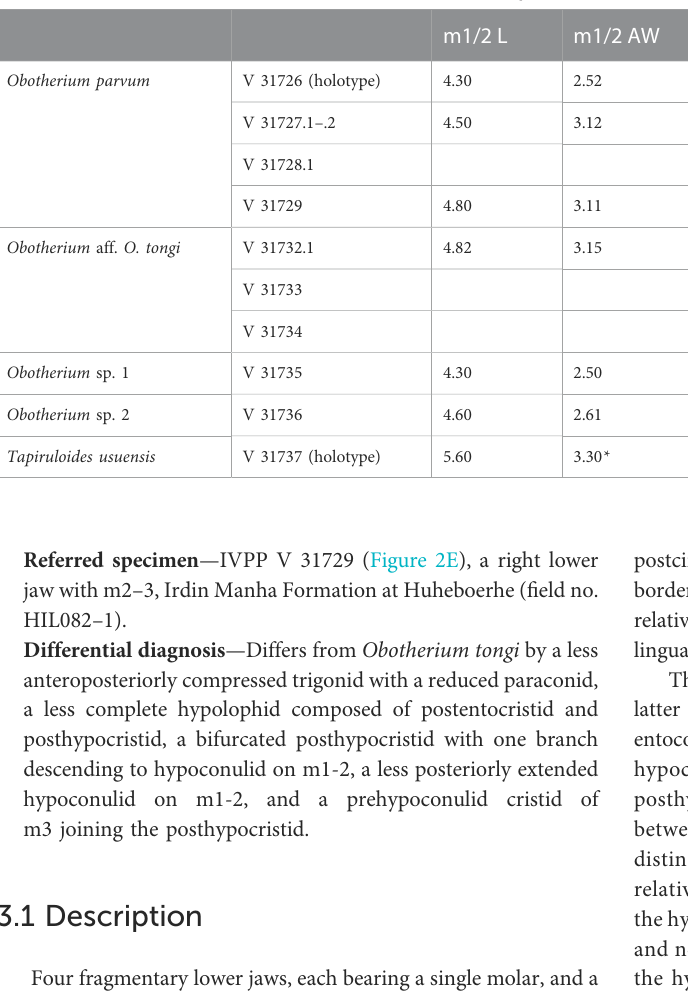
TABLE 1 Measurements of the lower molars of Obotherium and Tapiruloides (in mm) (*: approximate